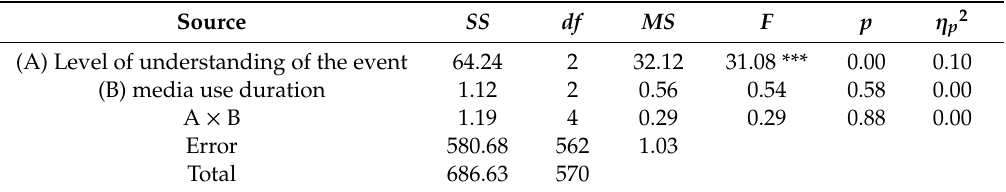
Table7. Varianceanalysisofthelevelofunderstandingofeventsandthemediadurationonoverallsatisfaction. Source SS df MS F p η p